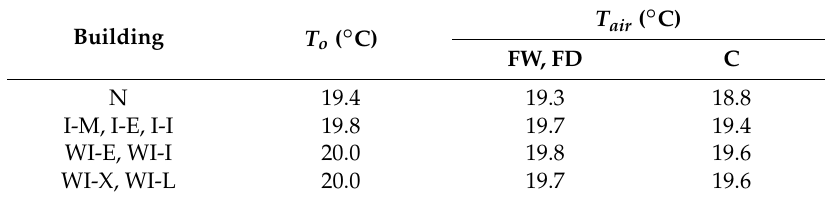
Table 5. Mean value of operative temperature and air temperature setting of the radiant simulations.